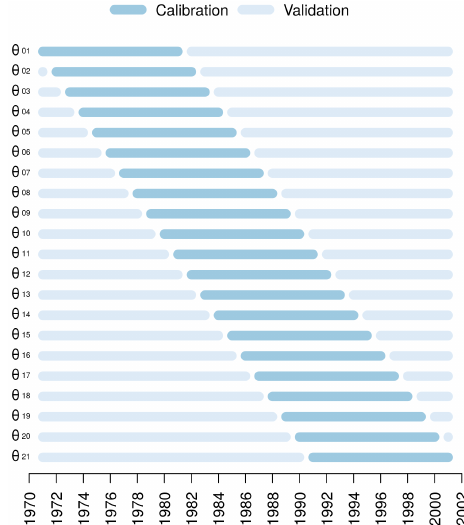
Figure 3. Illustration of the rolling calibration period methodology: 21 parameter sets θ can be identified for each